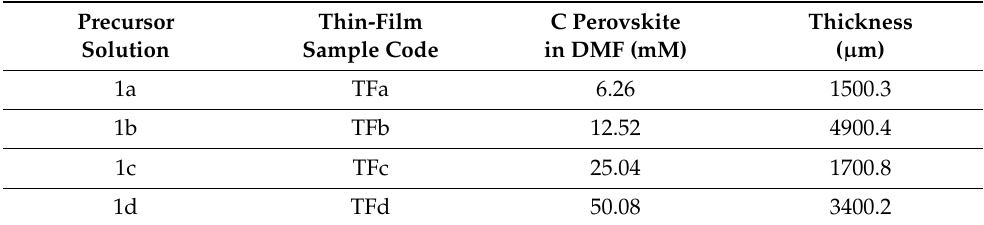
Table 3. Thin-Film samples, their precursor solutions, thickness of the films, and concentration of perovskite in each sample.